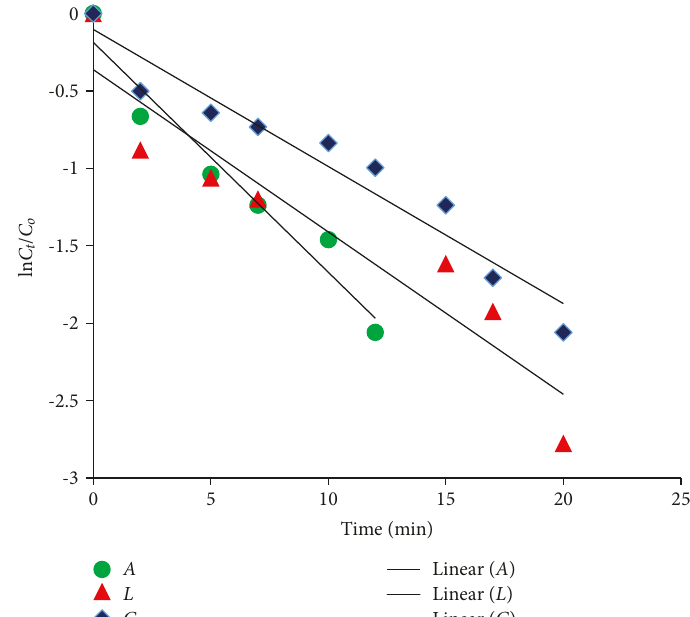
C Figure 8: Plot of ln( C ) as a function of time (min) for reduction of MB; A : reduction of MB in the presence of ascorbic acid and 0.25 g of t / 0 CPUF, L : reduction of MB in the presence of Citrus limon extract and ascorbic acid (50 :50) and 0.25g of CPUF, and G : reduction of MB in the presence of Psidium guajava extract and ascorbic acid (50 :50) and 0.25g of